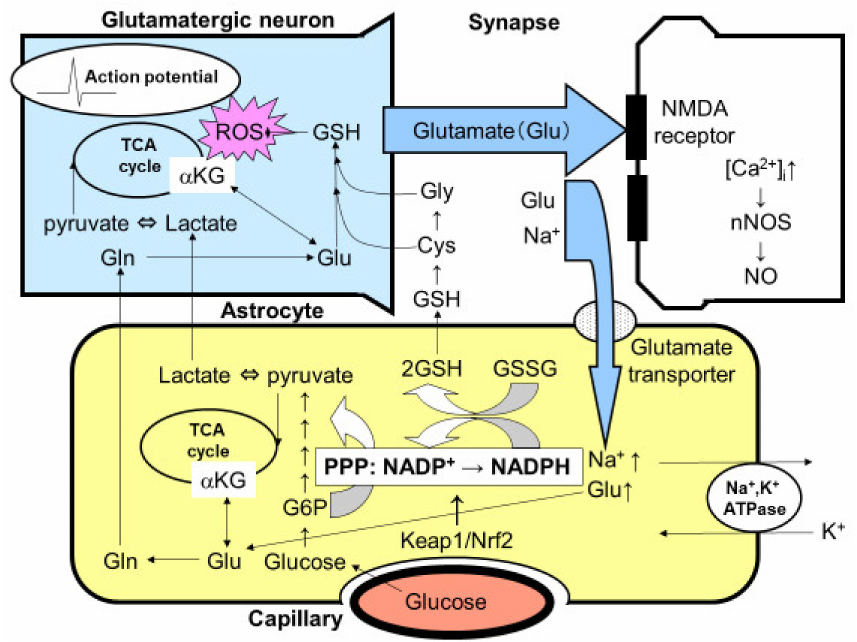
Figure 2. Tripartite synapse consisting of glutamatergic neurons and astrocytic endfoot. Glutamate (Glu) is a ubiquitous excitatory neurotransmitter that causes cell death through the N-methyl-D- aspartate (NMDA) receptor-mediated intracellular Ca 2+ concentration ([Ca 2+ ] i ). The elevation of [Ca 2+ ] i activates neuronal nitric oxide synthase (nNOS) leading to the production of nitric oxide (NO), which is a major cell death mediator of neurons. Released glutamate, therefore, must be taken up by astrocytic Na + -dependent glutamate transporters. Glutamate uptake stimulates astrocytic Na + , K + -ATPase, thereby enhancing glycolytic metabolism (aerobic glycolysis) in astrocytes. The increased lactate/pyruvate, end-products of glycolysis, then fuel the neuronal tricarboxylic acid (TCA) cycle as energy substrates (astrocyte–neuron lactate shuttle model). Mitochondria are a major source of reactive oxygen species (ROS), which injure neurons both acutely and chronically, in the central nervous system. Glutamate in astrocytes is converted into glutamine (Gln) and then recycled back to glutamatergic neurons (glutamate–glutamine cycle). Glu can also serve as an energy substrate, α -ketoglutarate ( α KG). The activation of glycolysis in astrocytes increases flux into the pentose-phosphate pathway (PPP), a shunt pathway of glycolysis, at glucose 6-phosphate (G6P). In addition to allosteric regulation, the transcriptional regulation of the rate-limiting enzyme of PPP, G6P dehydrogenase, is under the Kelch-like enoyl-CoA hydratase-associated protein 1 (Keap1)/nuclear factor erythroid 2 p45 subunit-related factor 2 (Nrf2) system. Increased flux to the PPP increases the ratio of the reduced form and the oxidized form of nicotinamide adenine dinucleotide phosphate (NADPH/NADP + ), which is used to convert the oxidized form of glutathione (GSSG) to the reduced form of glutathione (GSH). Glutathione can be transferred to neurons via Gln, cysteine (Cys), and glycine